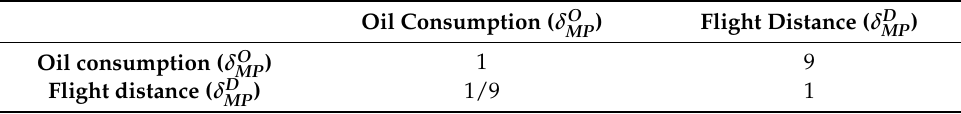
Table 11. Judgmental matrixes of UAV performance alternative hierarchy of mission point.